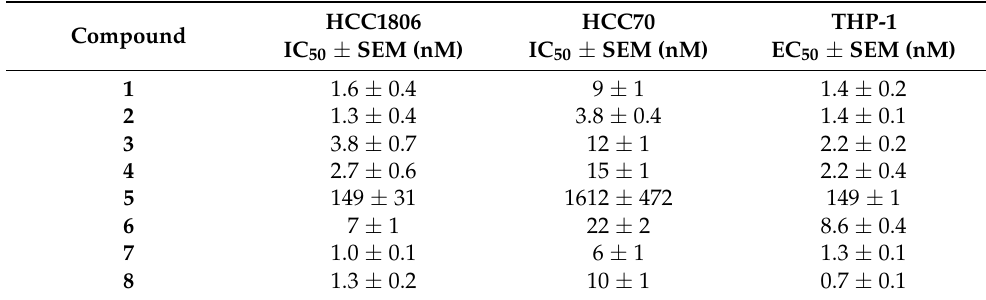
Table 2. Potency of 1 – 8 for growth inhibition of BL2 subtype TBNC cells (IC 50 ) or differentiation of THP-1 cells (EC 50 ).